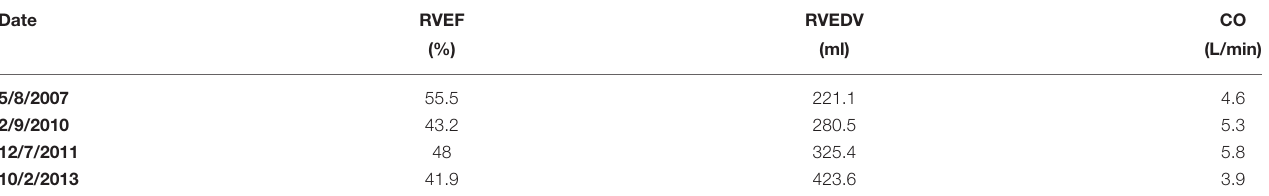
TABLE 1B | Cardiac MRI data for patient over several years prior to VAD implantation.